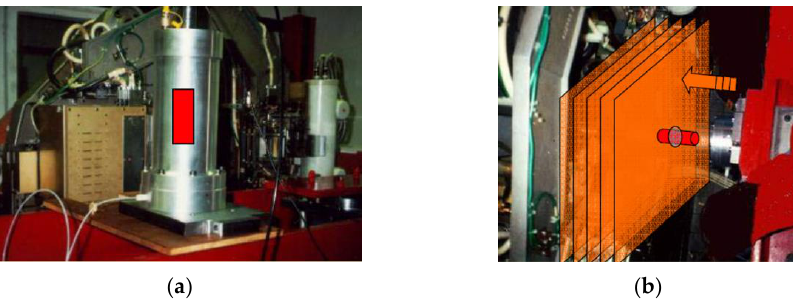
Figure 14. Tomotriax: ( a ) triaxial cell with selected sample, ( b ) triaxial cell placed in CT ready for operation in the scanner; (source: photo of Desrues J. from 3S-R Grenoble and LMA Marseille, 2000; after [109], available via 2021 Desrues’ permis- sion).